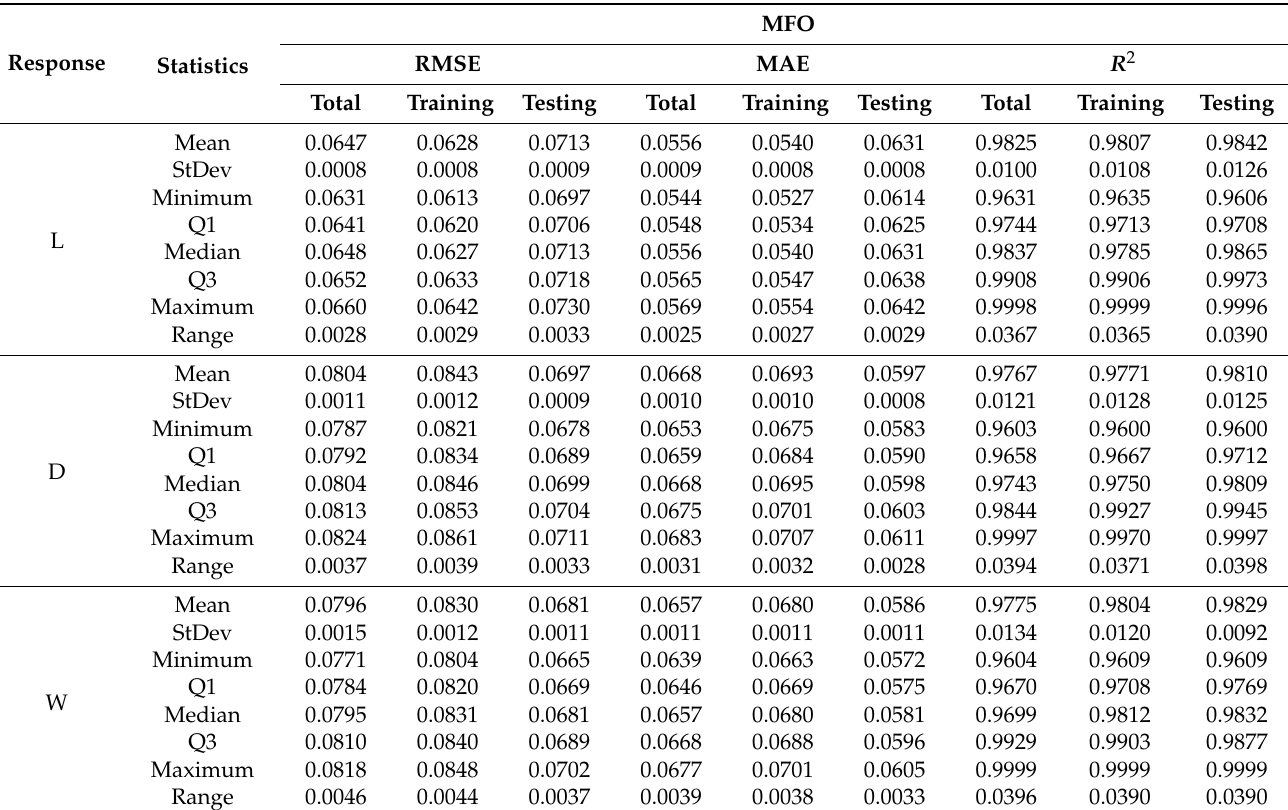
Table 11. Statistical analysis of output obtained by the MFO algorithm.